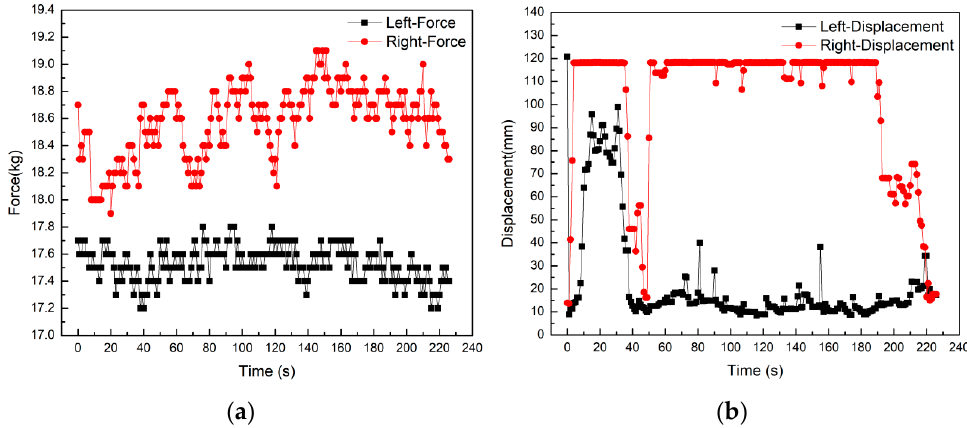
Figure 20. ( a ) Force curve of in situ left steering; ( b ) displacement curve of in situ left steering.